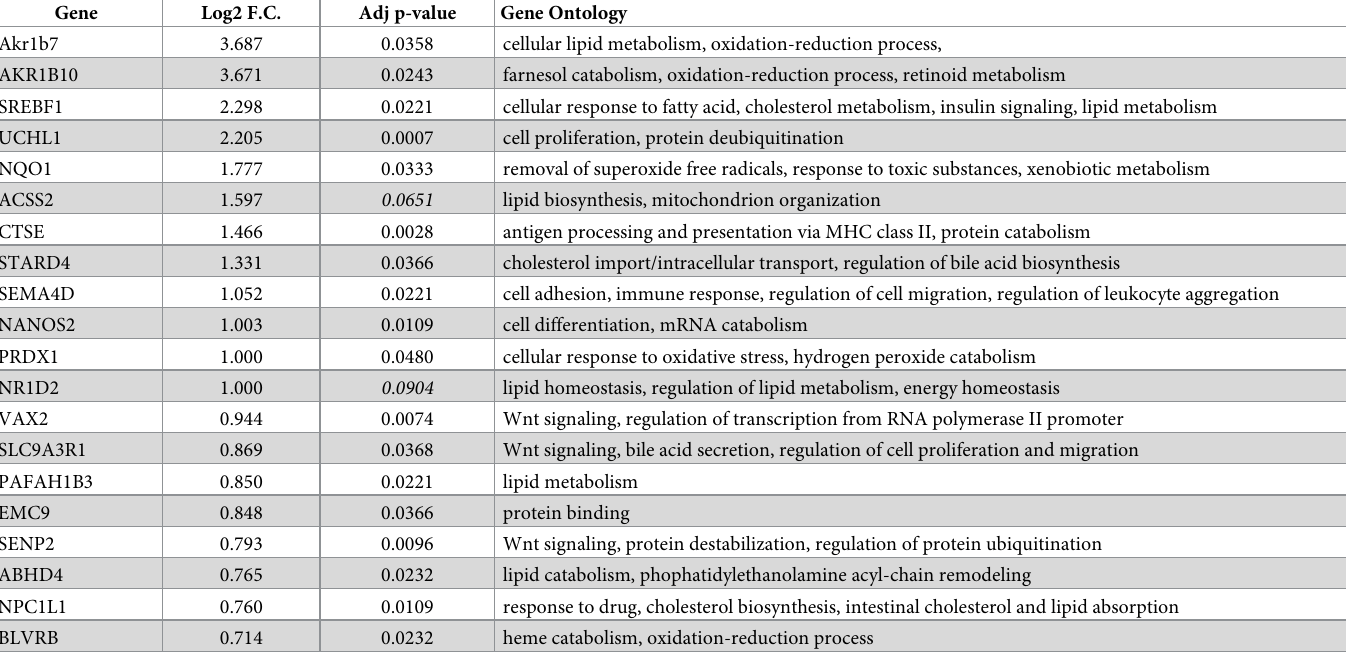
Table 4. Top differentially expressed genes in SIV+ ART infant